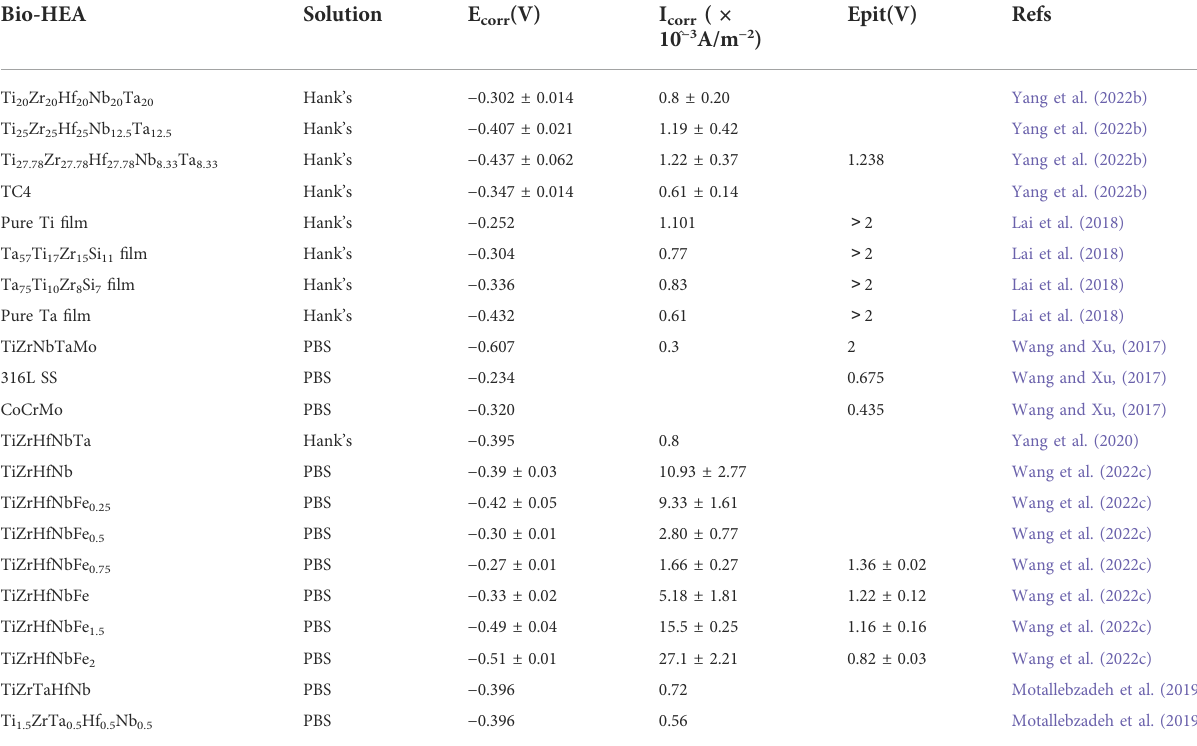
TABLE 2 Electrochemical parameters of the relevant Bio-HEAs in simulated human solutions.